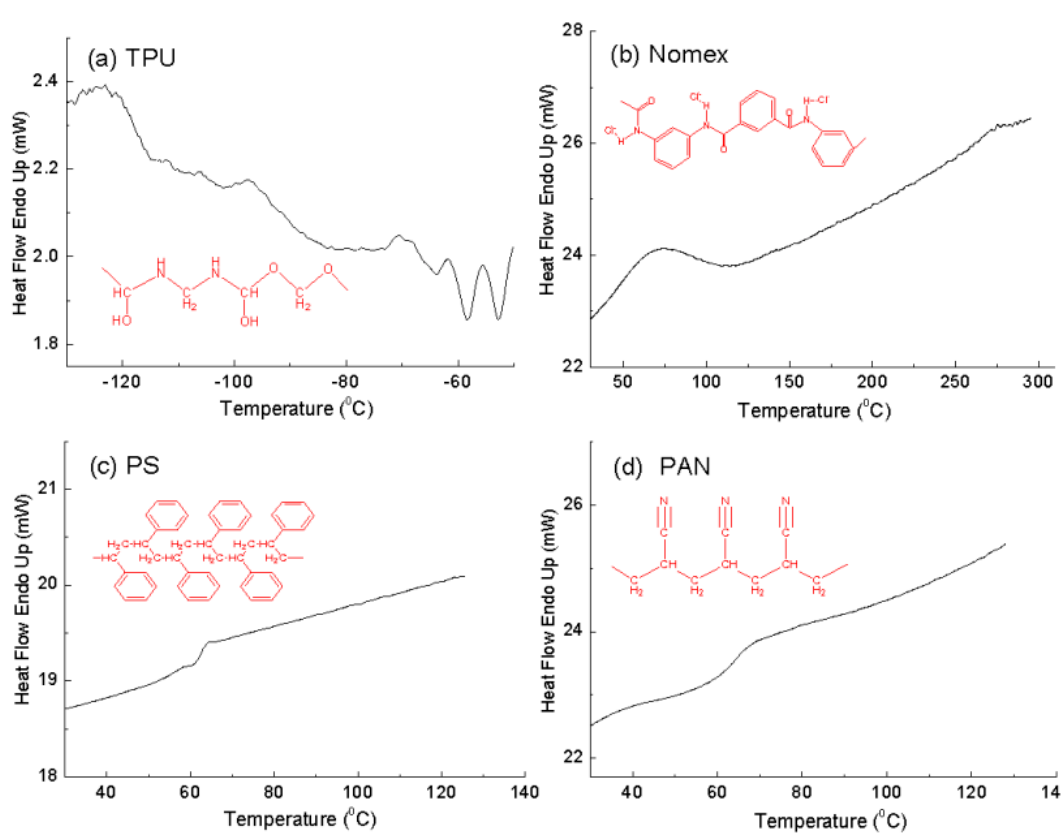
Figure 2. Differential scanning calorimetry (DSC) thermograms and molecular formulas of the four polymer components: ( a ) TPU, ( b ) Nomex, ( c ) PS, and ( d ) PAN.